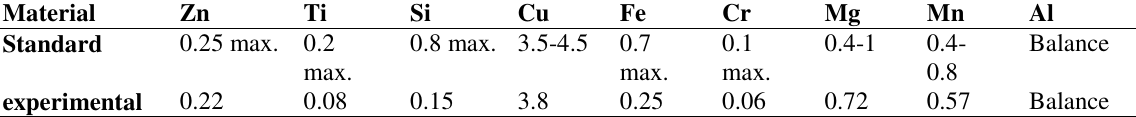
Experimental and standard chemical composition of 7049 AA in (cid:11) (cid:12) % Material